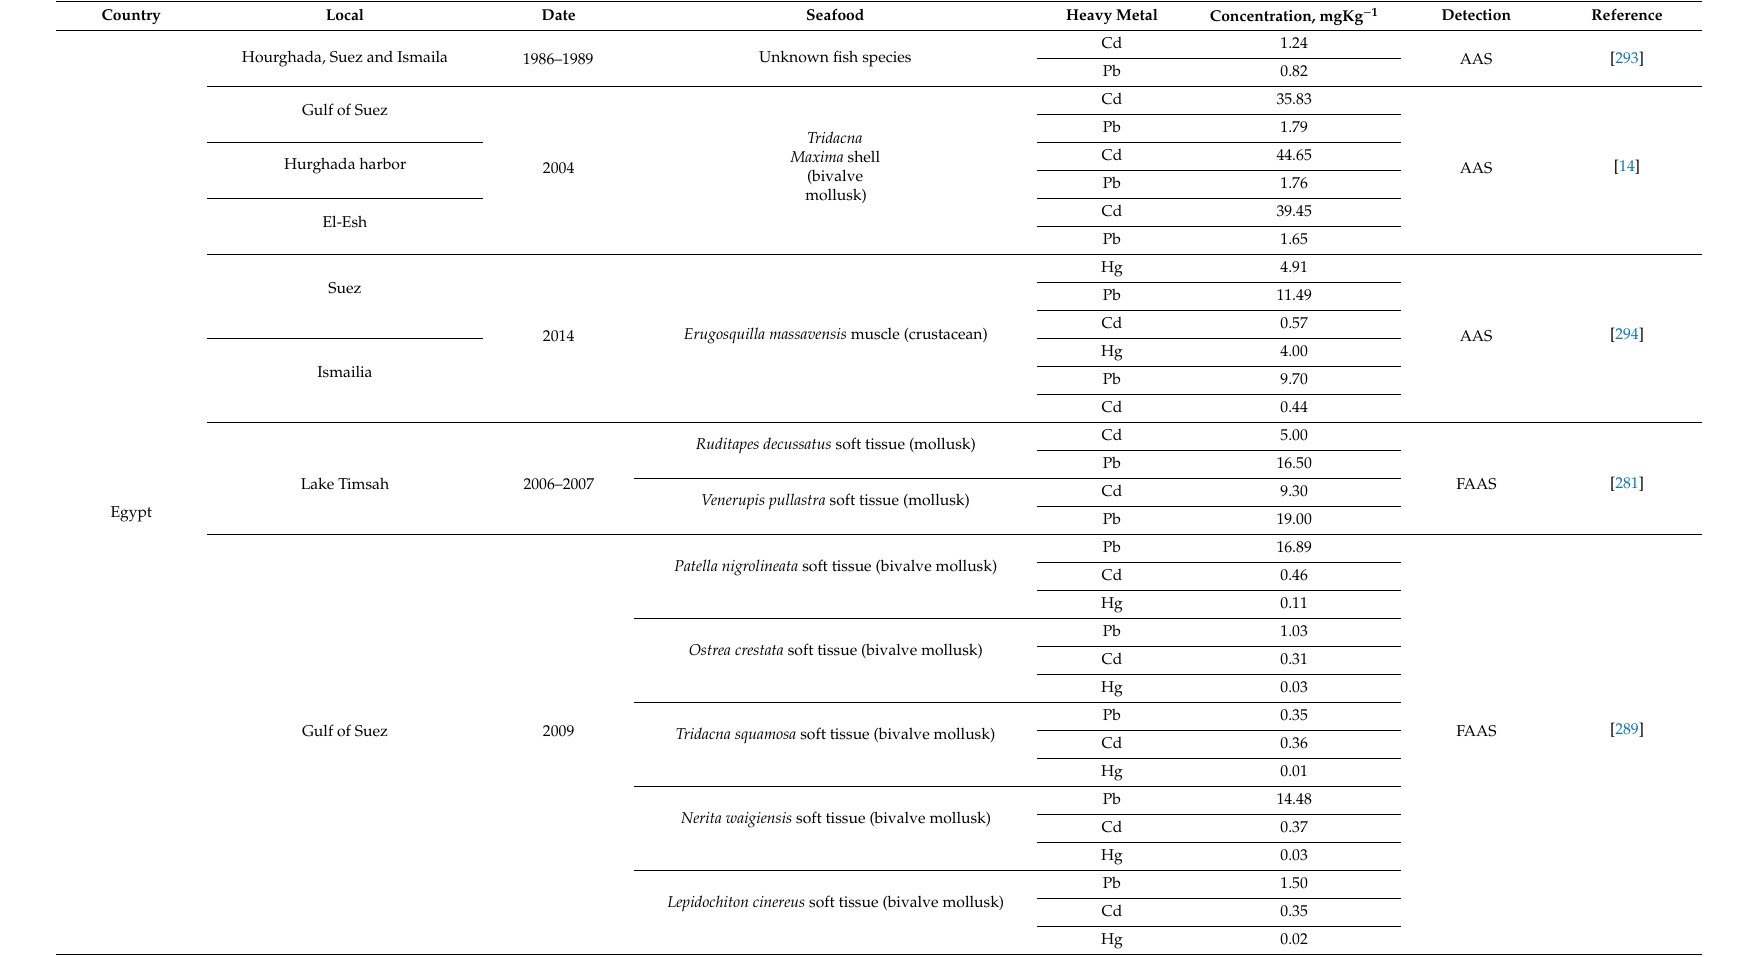
Table 4. Concentration of cadmium, mercury and lead in seafood from African countries bordering the Indian Ocean and the Red Sea. Country